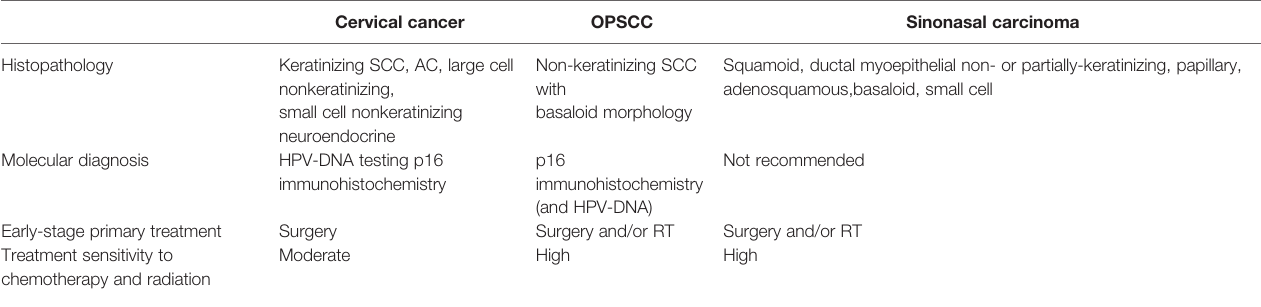
TABLE 2 | Summary of attributes of HPV-related Cervical cancer, OPSCC and Sinonasal